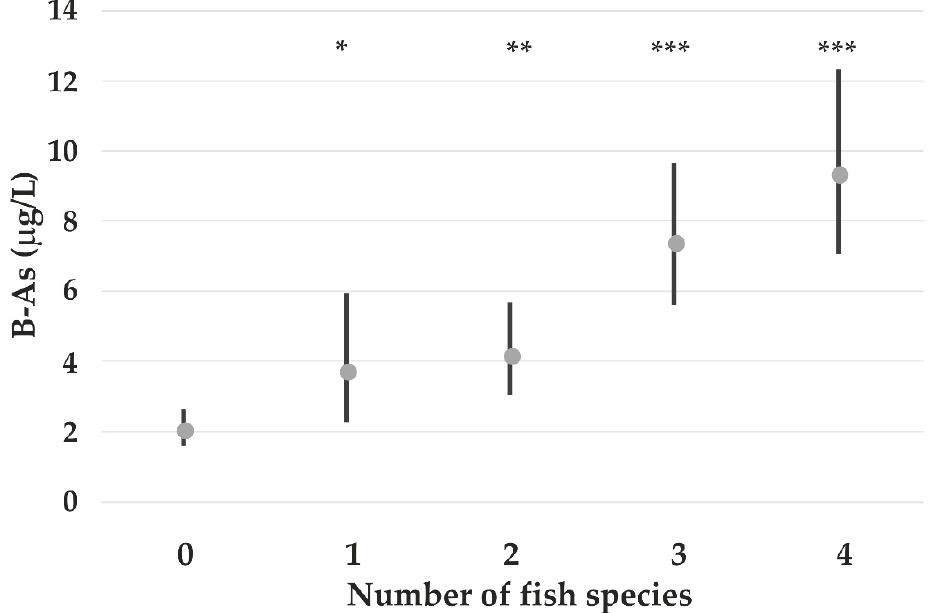
Figure 5. Geometric mean (and 95% CI) B-As concentrations among all participants according to number of selected fish species (navaga, rainbow smelt, pink salmon and Arctic char) they record to consume. The p -values (*** p < 0.001; ** p < 0.01; * p < 0.05) refer to comparisons with the subgroup reporting to consume none of the four species.